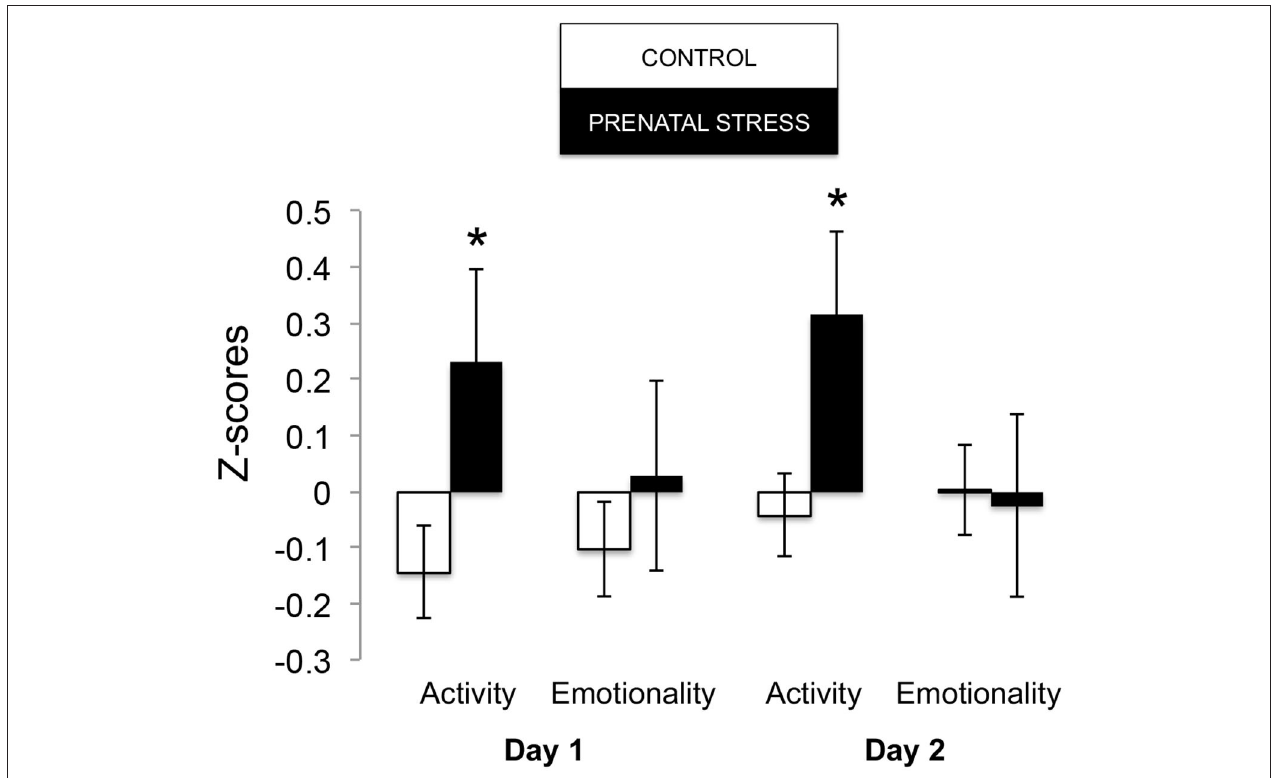
FIGURE 1 | Effects of prenatal stress on Holding cage Activity and Emotionality during biobehavioral assessment between offspring of prenatally stressed mothers ( n = 39) and control mothers ( n = 149). Means are presented ± standard error of the mean. * p < 0.05.